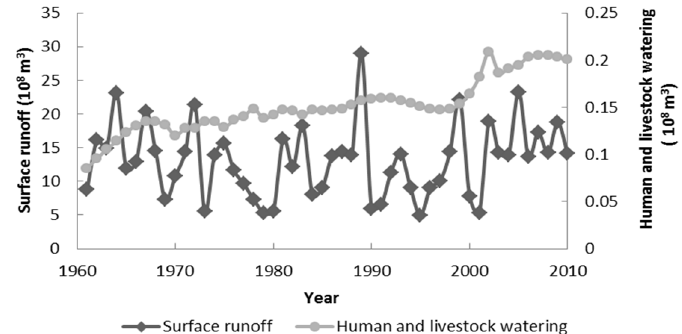
Figure 7. Total surface runoff and human and livestock water consumption in the Qinghai Lake catchment.